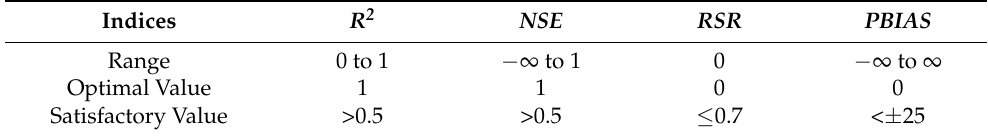
Table 2. Model performance evaluations for monthly discharge simulation [63–65].